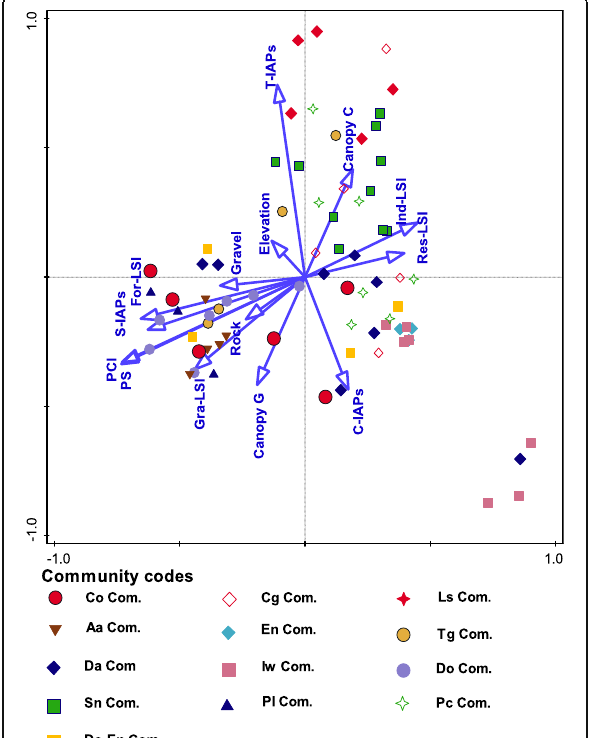
Fig. 3 Constrained ordination CCA for vegetation communities across the fifteen forest patches along the Durban Metropolitan Open Space System. Blue arrows and corresponding labels represent the direction and degree of various environmental variables (See Table 2 for details)